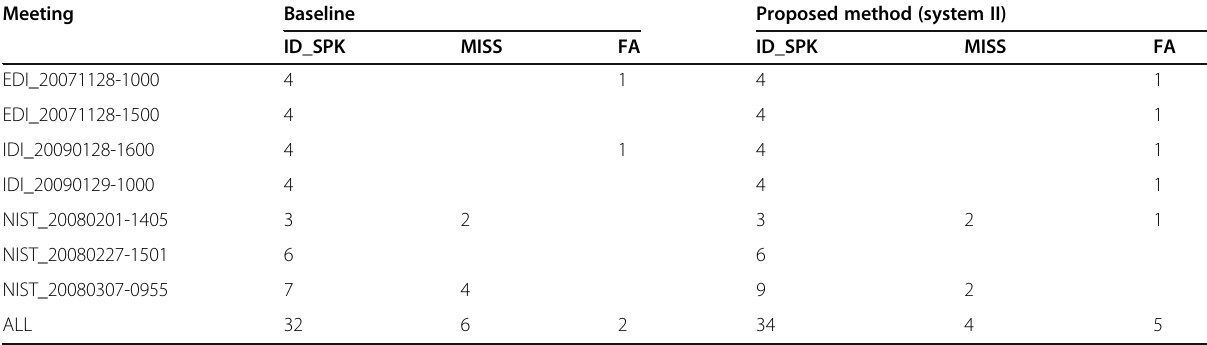
Table 6 Number of identified speakers, missed speakers, and false-alarm speakers for rt09 and all the systems tested Meeting Baseline Proposed method (system II)